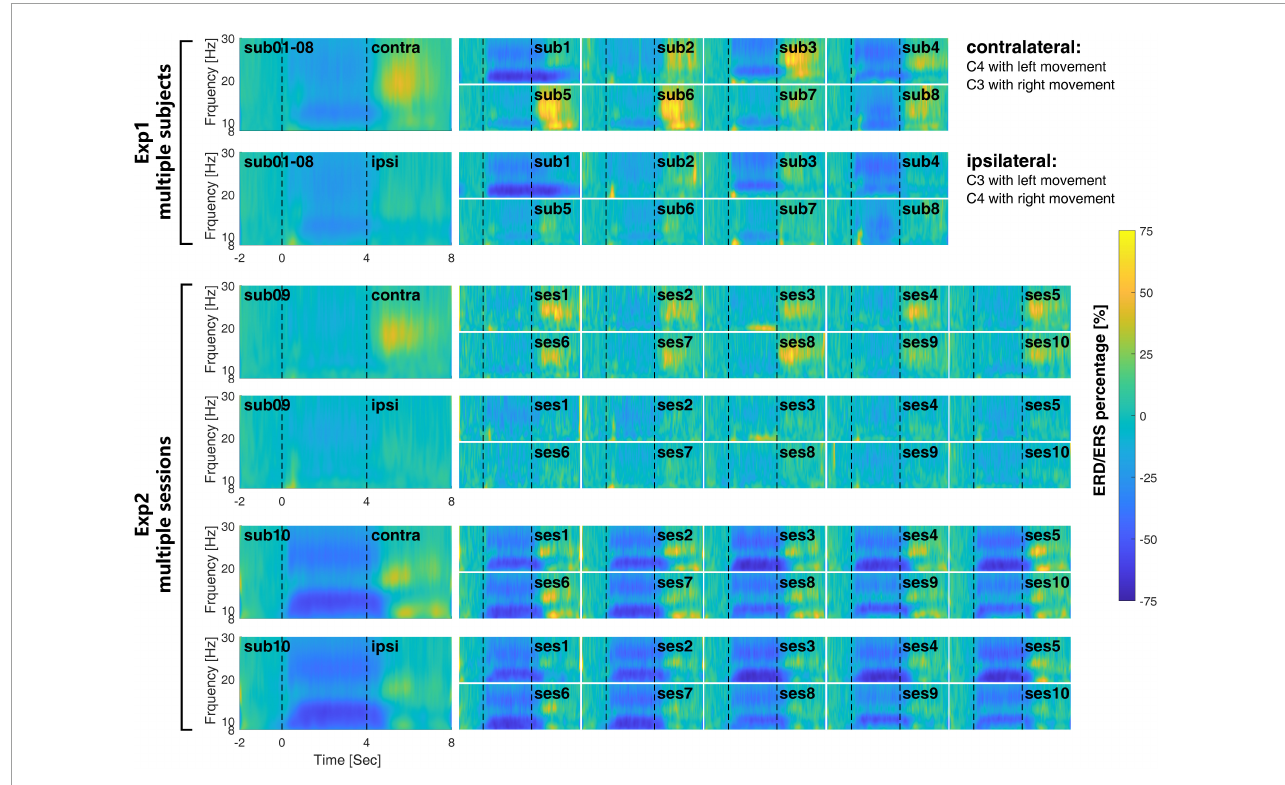
FIGURE4 The inter- and intra-subject variability of the time-frequency response during the MI-BCI. The large figures on the left are the averaged time frequency response cross-subject in Exp1 and cross-session in Exp2. The inter-subject variability in Exp1 is much larger than the intra-subject variability in Exp2.